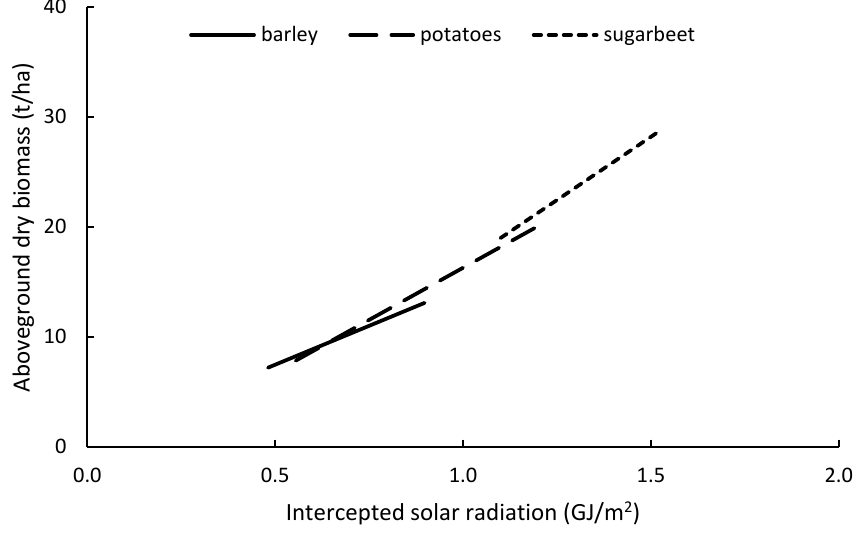
Figure 3. Relationship between above ground biomass and intercepted solar radiation (from the Monteith approach, redrawn from Monteith [103]).